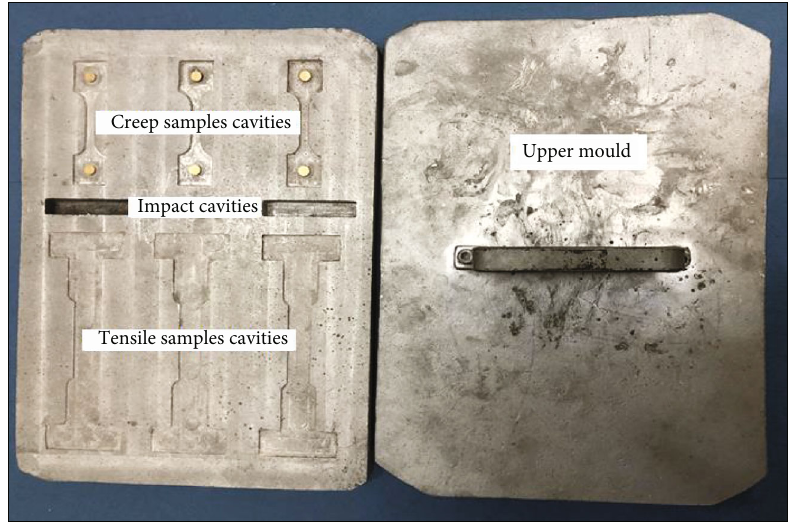
Figure 1: Iron compression mold after machining and